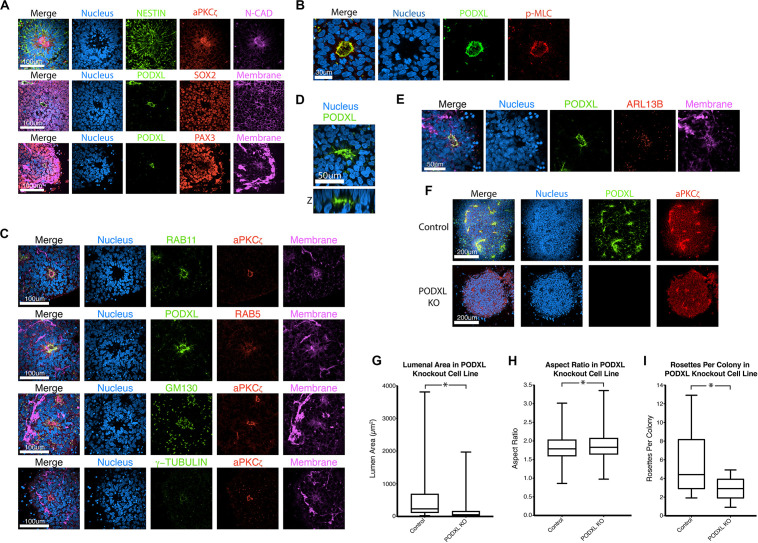
Characterization of NPC rosettes. (A–E) Immunolocalization analyses of NPC rosettes with indicated markers: neural markers = NESTIN, N-CADHERIN (N-CAD), SOX2 and PAX3; apical markers = aPKCζ and PODXL; myosin activity marker = p-MLC; and organelle markers = RAB11 (recycling endosome), RAB5 (early endosome), GM130 (Golgi), γ-TUBULIN (centrosome) and ARL13B (primary cilium). In (D), the X-Z plane is shown to reveal the internalized PODXL+ apical domain. Note that the rosette that is stained for NESTIN, aPKCζ, N-CAD and DNA is identical to the Day 10 + 24 hr sample in Figure 1B. (F) Confocal fluorescent images of control and PODXL-KO NPC rosettes stained with indicated markers. (G–I) Quantitation of lumenal area (G), aspect ratio (H) and number of rosettes per colony (I) of control and PODXL-KO cells. Student’s t-test was used for statistical analyses: ns = p > 0.05; *p ≤ 0.05.